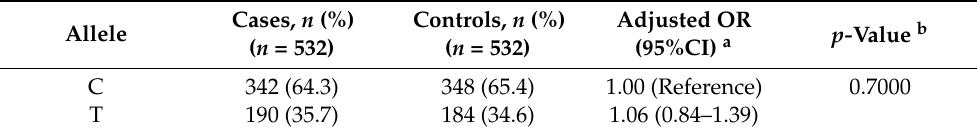
Table 5. Distributions of H19 rs217727 genotypes between childhood leukemia and control